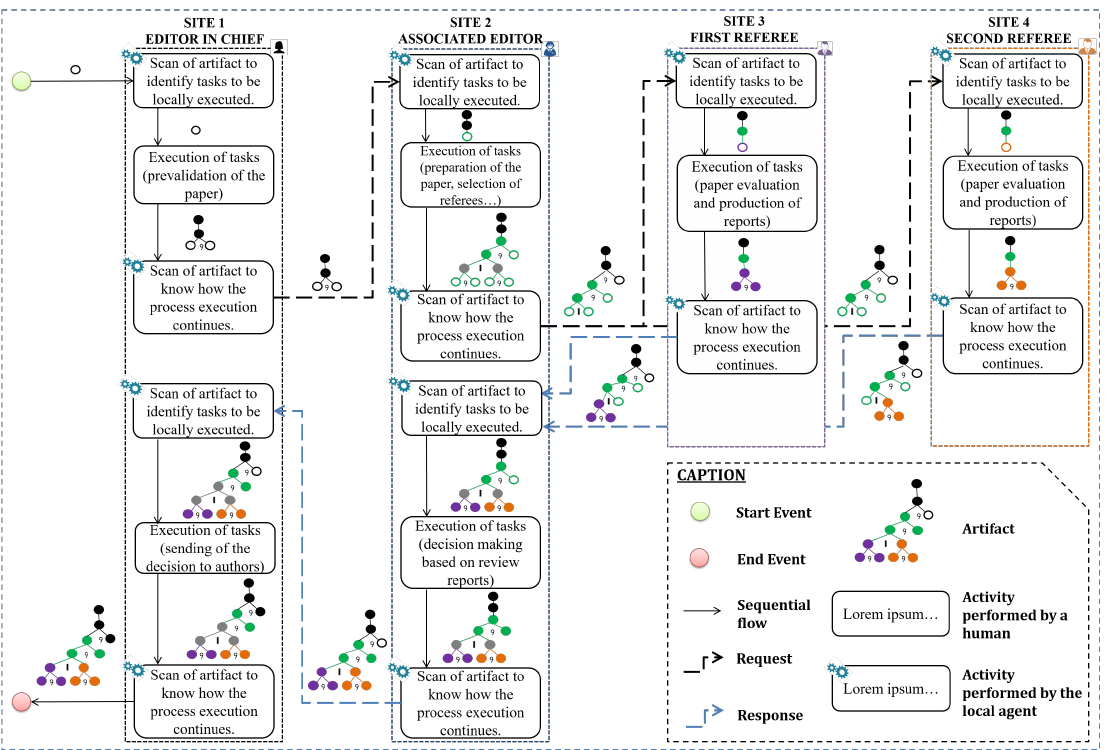
Figure 5: An overview of the artifact-centric execution of the peer-review